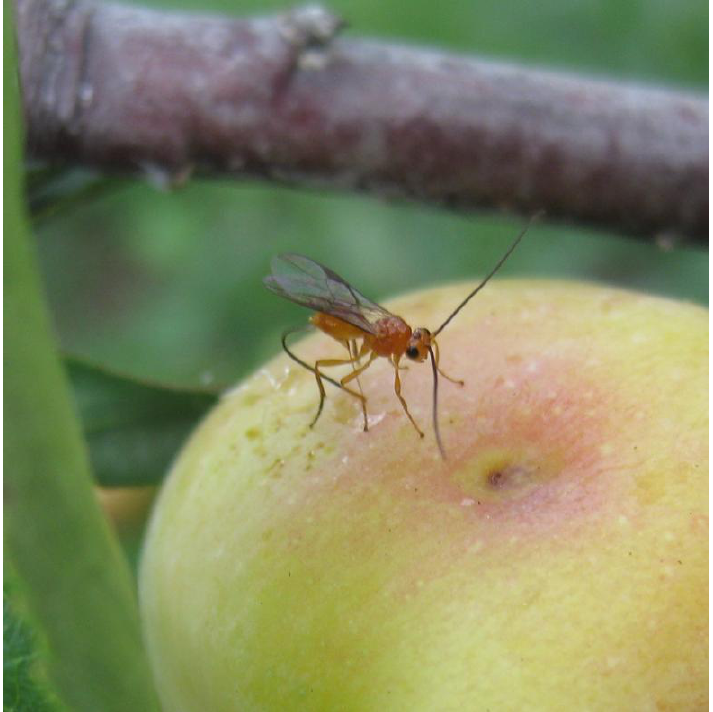
Figure 1. A female Diachasmimorpha